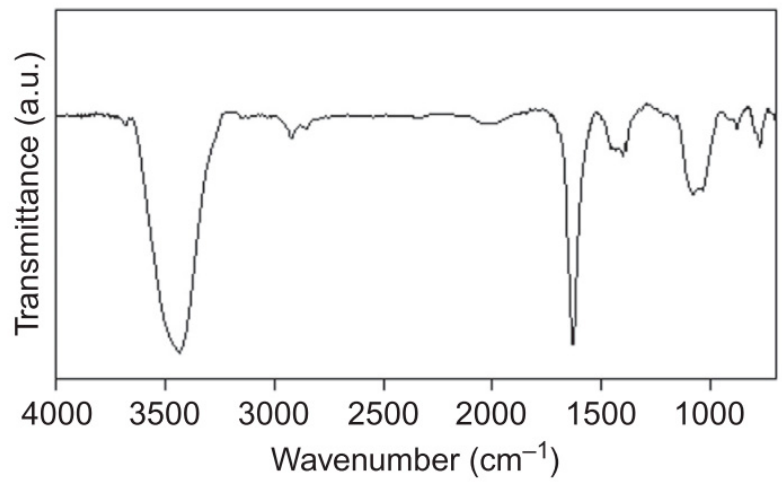
Figure 6. FTIR spectrum of raw CNT. Reprinted/adapted with permission from Ferreira et al. [79] (2019) Elsevier Copyright.